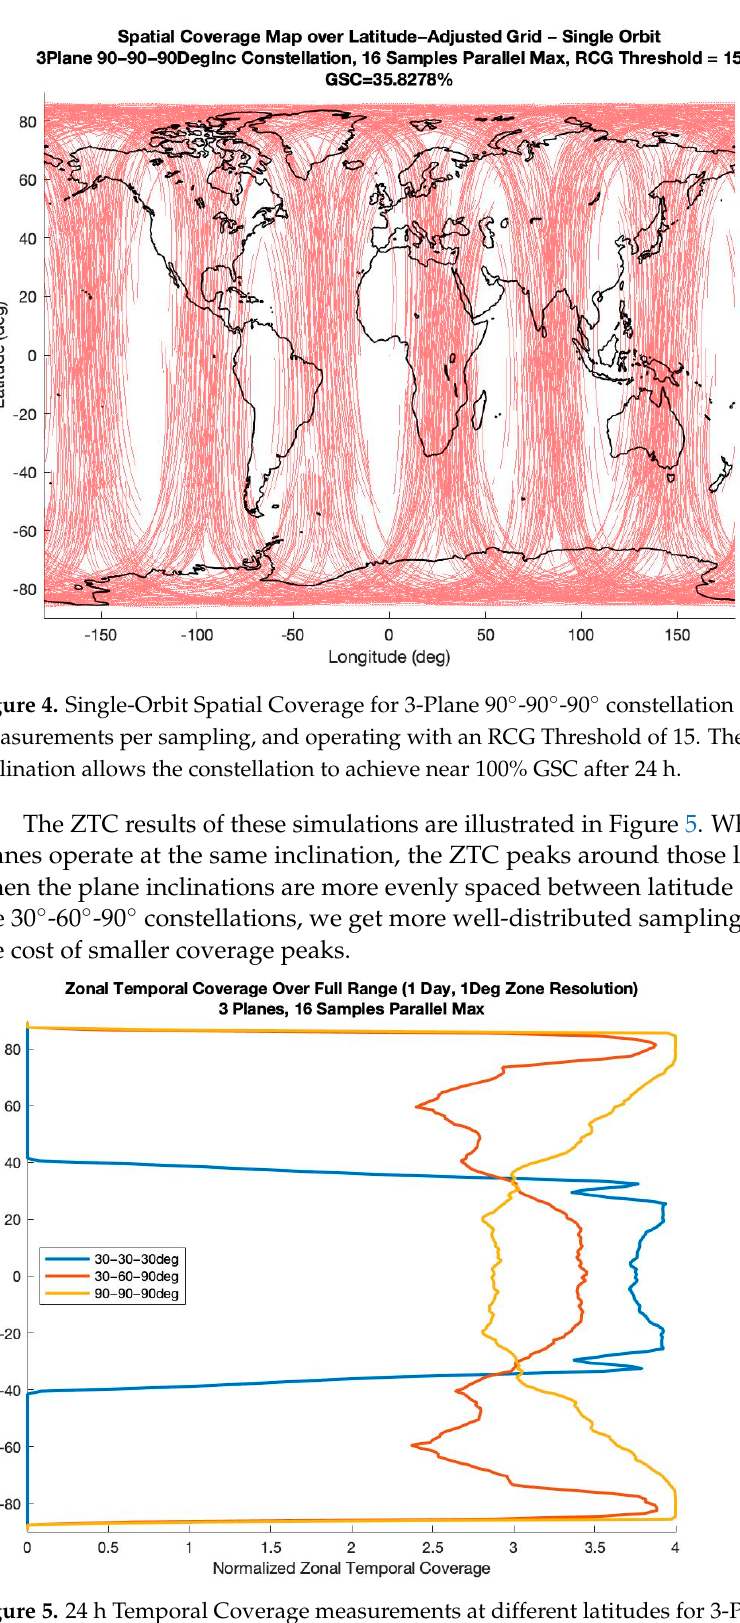
Figure 5. 24 h Temporal Coverage measurements at different latitudes for 3-Plane constellations at 800 km, 16 parallel measurements per sampling, and operating with an RCG Threshold of 15. Raising the inclination of individual planes or the entire constellation can alter which latitudes are visited most